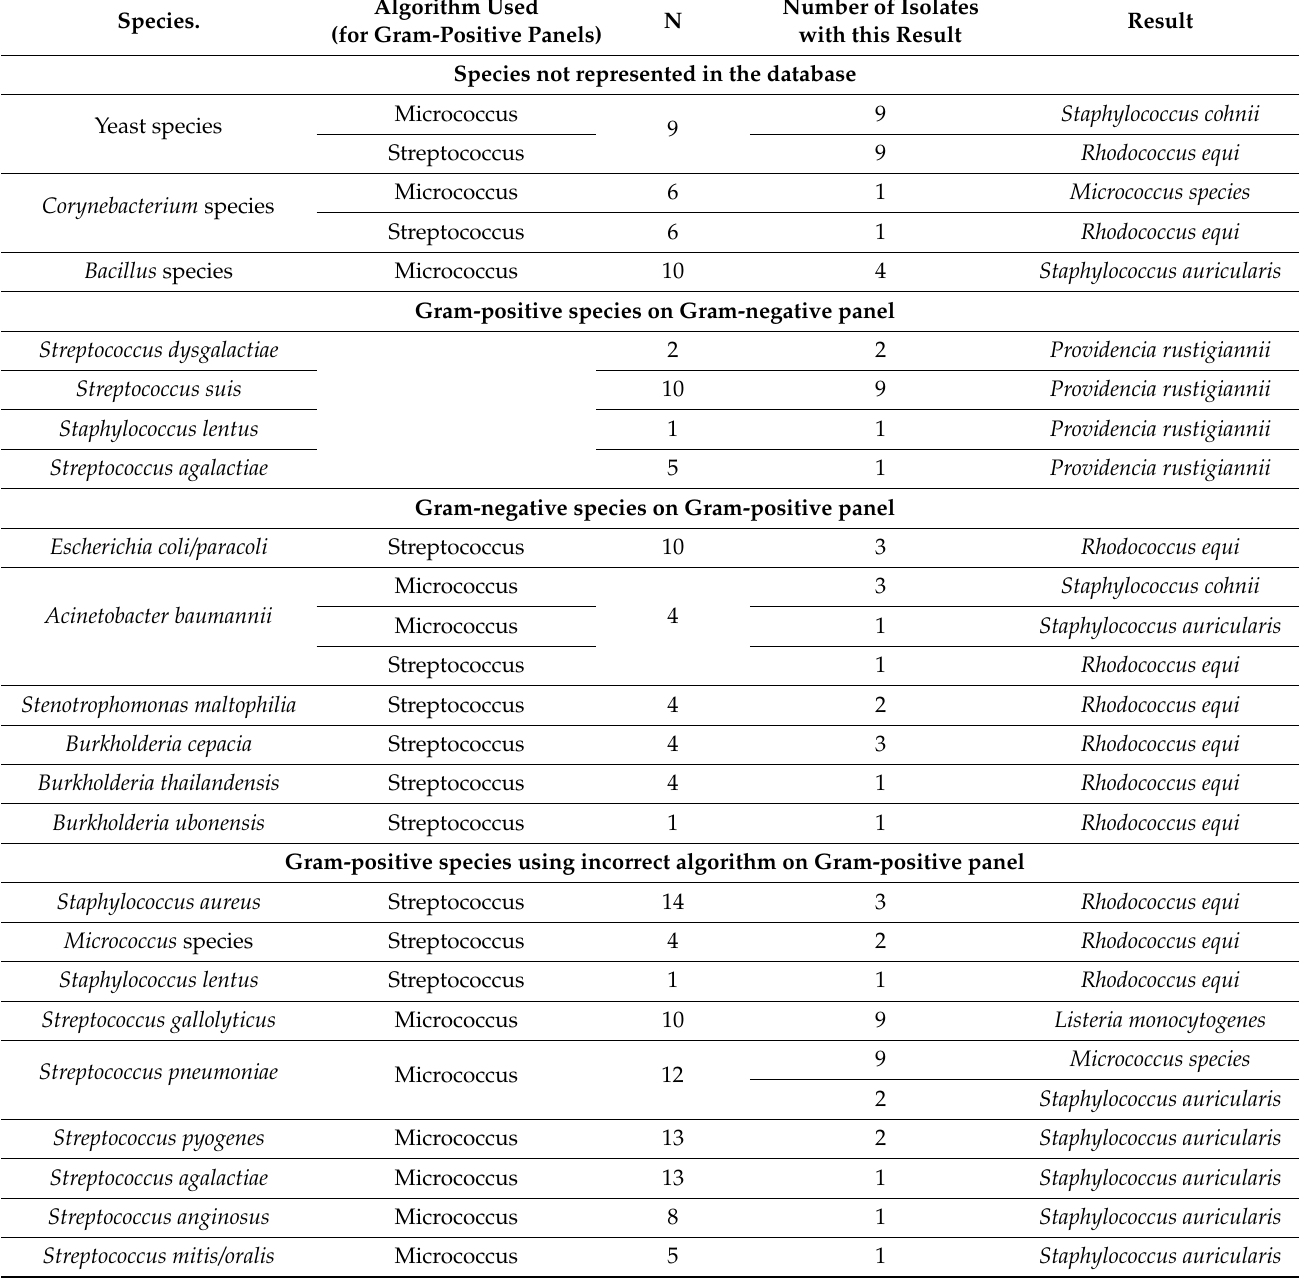
Table 5. Most frequent incorrect identifications with high probability score for species not represented in the database or “incorrect” use of the panels (Gram-positive isolates inoculated on Gram-negative panels and vice versa, Streptococcus using Micrococcus/Staphylococcus algorithm and vice versa). N = total number of isolates tested.